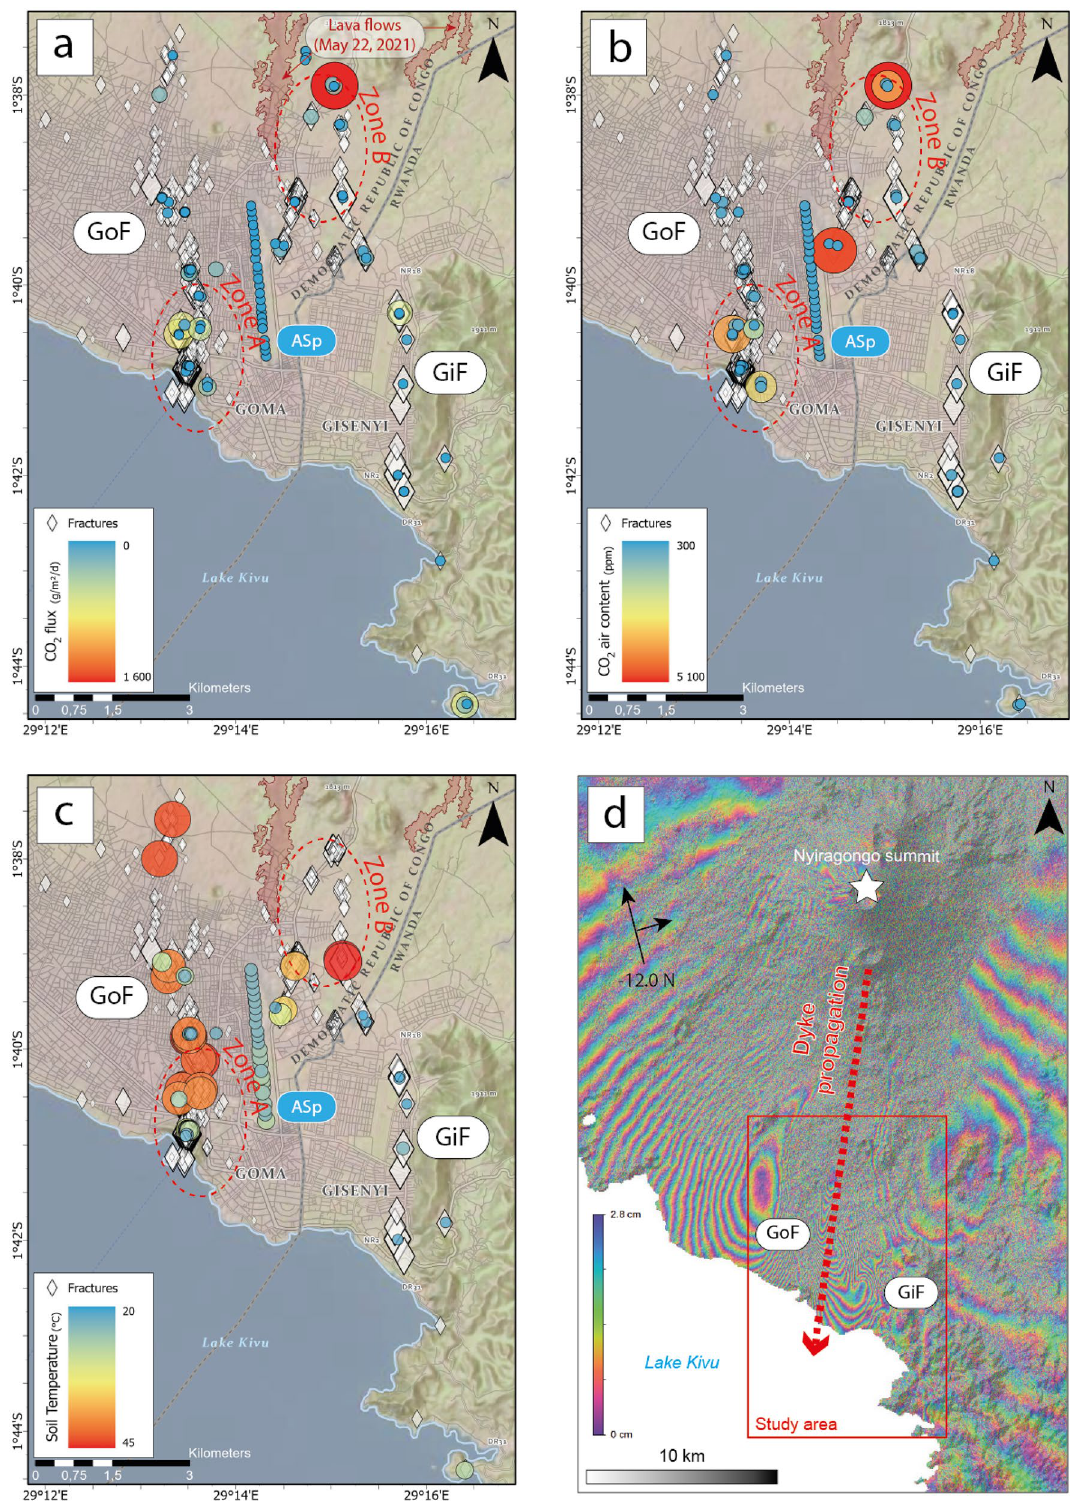
Figure 3. Maps produced from the results of the survey performed by the international scientific team and local institutes: ( a ) CO 2 flux from fractures and soils, ( b ) CO 2 content in the air close to the soil, ( c ) temperature within the fractures and in the soil (20 cm-depth). ( d ) Interferogram showing the ground deformation related to the dyke propagation. The large-scale deformation pattern (Supplementary Fig. S4) displays two lobes with opposite axis 34 . The propagation path is therefore interpreted to be nearly North–South, similar to the network of fractures. Credits Attribution: Esri, NASA, NGA, USGS; RMLUA, OpenStreetMap, HERE, Garmin, METI/ NASA,